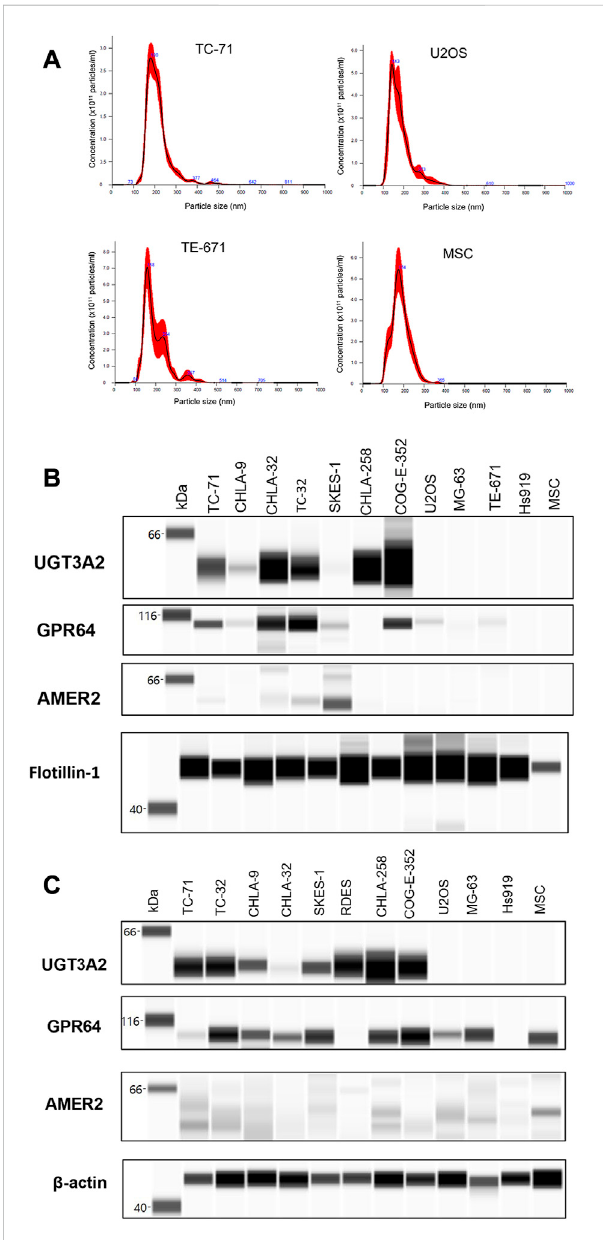
FIGURE 4 ValidationofEWScellandsEVProteinExpressionbyWesAnalysis (A) Representative NTA analysis plots for cell-derived sEVs, indicating the particle size range between 100 – 200 nm. Wes analysis for UGT3A2, GPR64 and AMER2 protein expression in (B) cell- derived sEVs and (C) cell